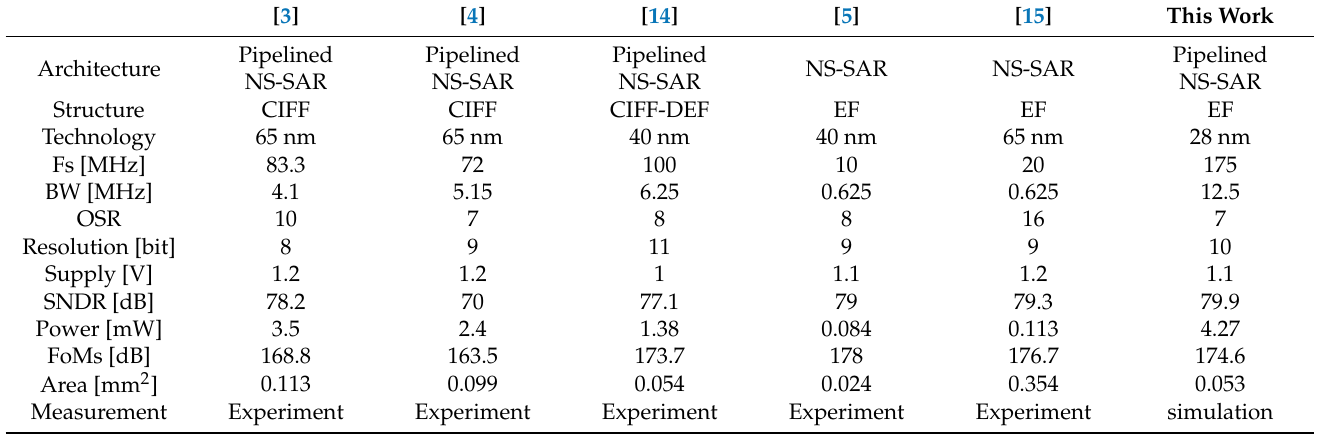
Table 1. Comparison table.